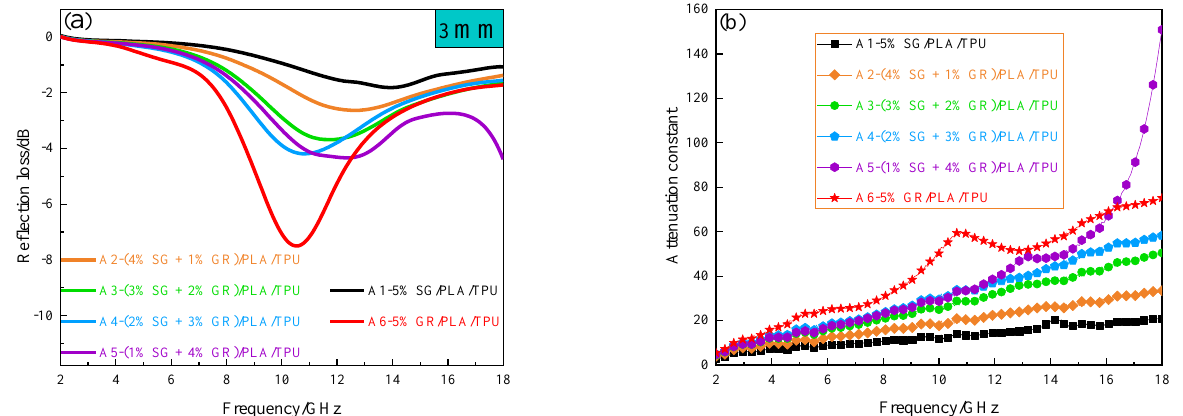
Figure 9. A 1 ~A 6 composites: ( a ) the curve of reflectivity with frequency at 3 mm thickness; ( b ) curve of attenuation constant with frequency.